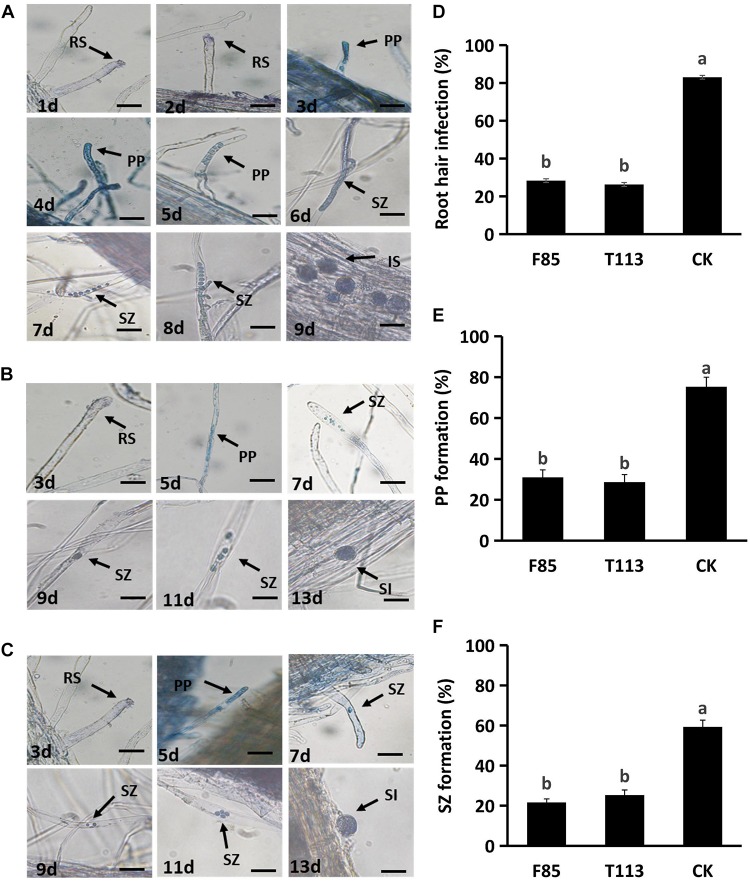
Inhibition of the infection process of P. brassicae on rapeseed root hairs by F85 and T113. (A) Root hair infection process of untreated control. The zoospores infected root hairs in 2 DAI, formed primary plasmodia in 3 DAI, secondary zoosporangia in 6 DAI and started secondary infection in 9 DAI. RS, resting spore; PP, primary plasmodia; SZ, secondary zoosporangia; SI, secondary infection. (B) Root hair infection process of T113 treatment. The zoospores infected root hairs in 3 DAI, formed primary plasmodia in 5 DAI, secondary zoosporangia in 7 DAI, and started secondary infection in 15 DAI. (C) Root hair infection process of F85 treatment. The zoospores infected root hairs in 3 DAI, formed primary plasmodia in 5 DAI, secondary zoosporangia in 7 DAI and started secondary infection in 15 DAI. (D) Percentage of root hair infection (%) after treated with F85 or T113. (E) Percentage of primary plasmodium formation (%). (F) Percentage of second zoosporangia formation (%). CK: water. Different letters indicate significant differences between treatments according to LSD test (P < 0.05). Capped lines represent standard errors.